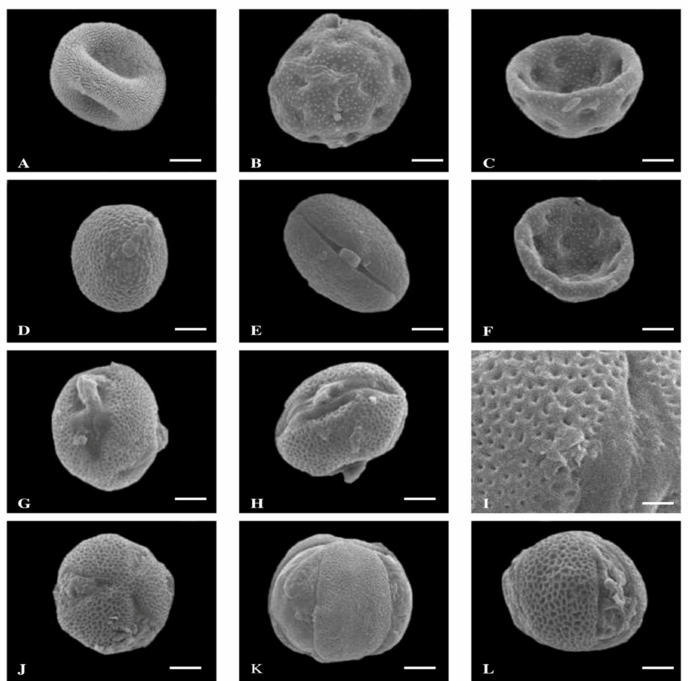
Figure 7. SEM images of pollen grains (Equatorial and Polar axis) and pollen surface ornamentation ( A – C ). The scale bar represents 5 µ m for Celosia aegentae ( D – F ), 10 µ m for Cenchrus ciliaris ( G – I ), 5 µ m for Chenopodium murale ( J – L ), and 5 µ m for Chorchorus depressus .